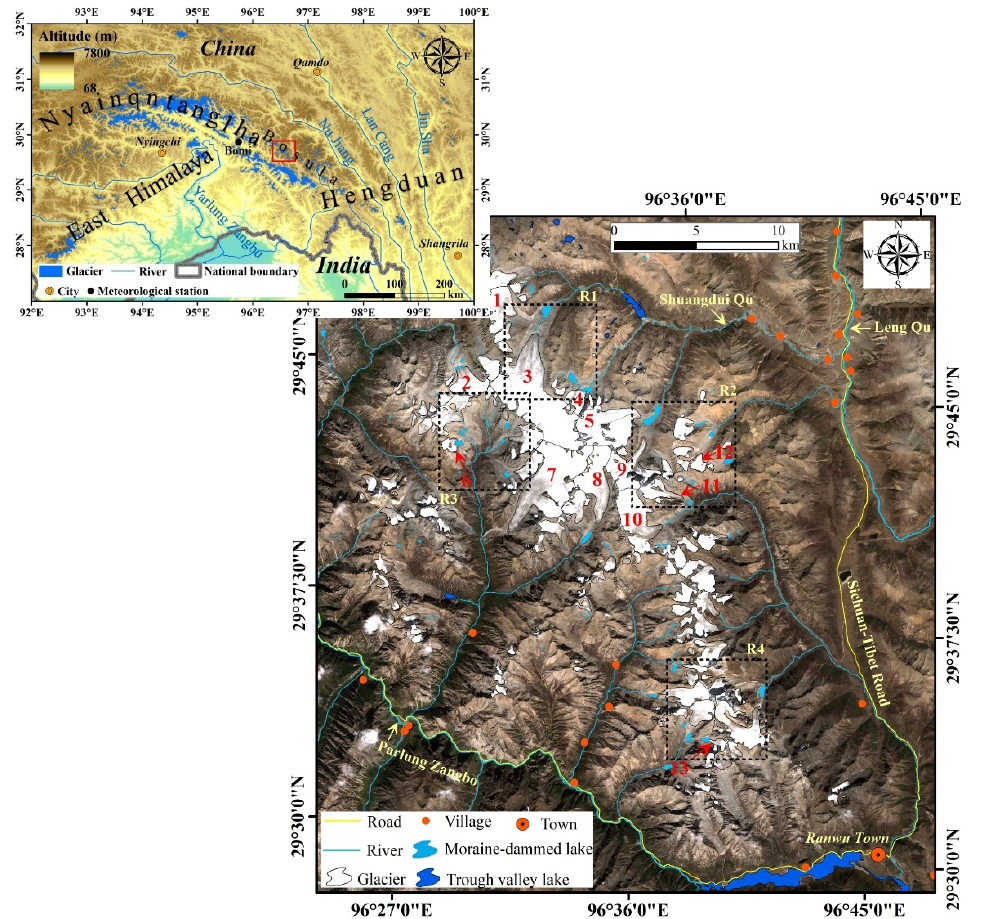
Figure 1. Location and overview of the study area. The background of the main panel is the Sentinel-2 image acquired on 12 October 2021. The red rectangle in the inset panel denotes the location of the study area. Dashed red rectangles R1–R4 in the main panel denote the areas shown in Figure 2a–d, respectively. Numbers 1–13 mark the glaciers mentioned in the text.